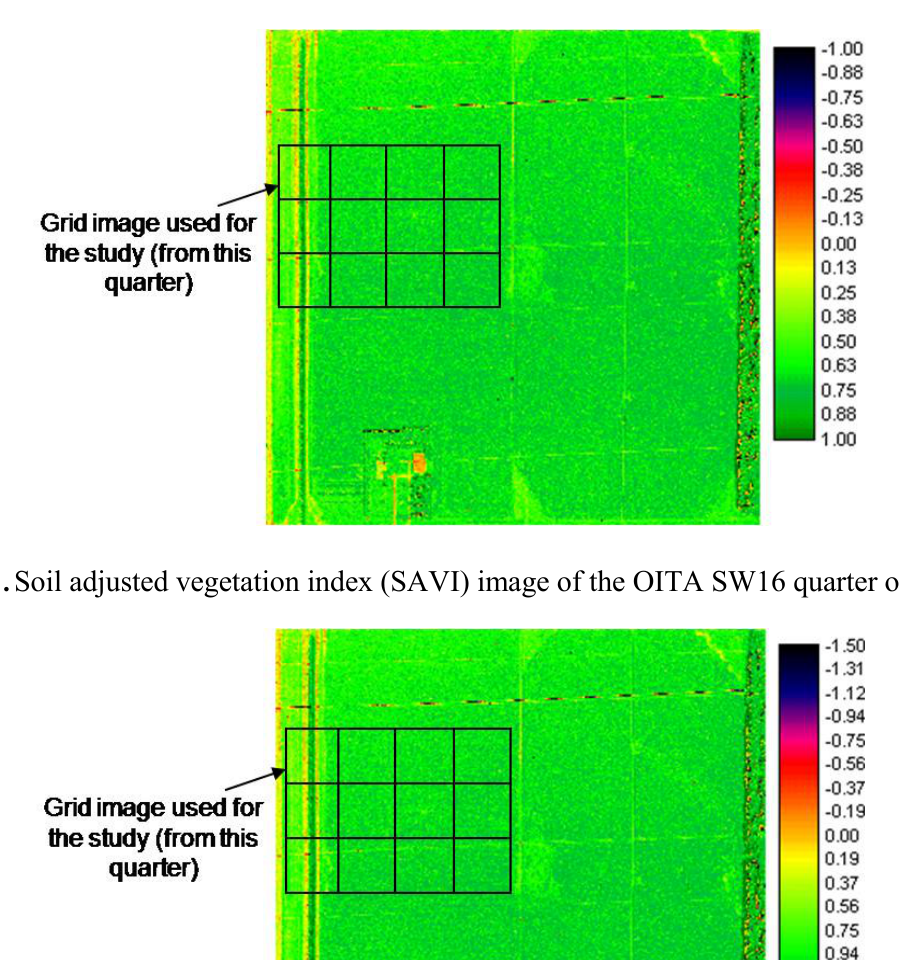
Figure 6. Normalized difference vegetation index (NDVI) image of the OITA SW16 quarter of 1999.